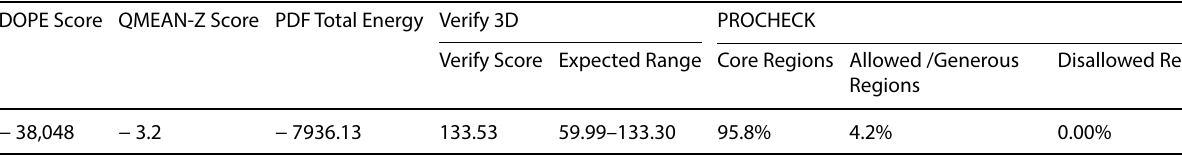
Fig. 3 Sequence alignment of mu-opioid and sst . Identical (dark blue), similar (light blue) residues, and transmembrane helices are shown 4 Table 1 DOPE, Verify 3D, and PROCHECK scores of the final model-built sst4 structure